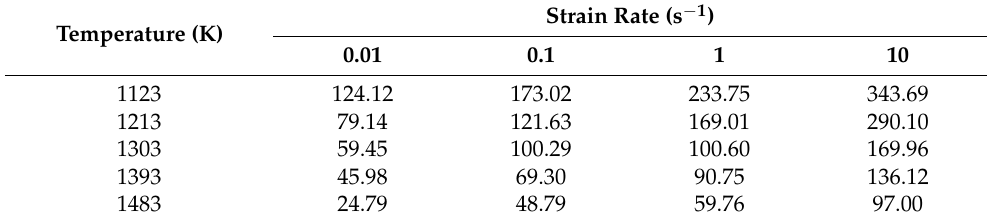
Table 4. Values of σ sat under temperatures of 1123–1483 K and strain rates of 0.01–10 s − 1 .